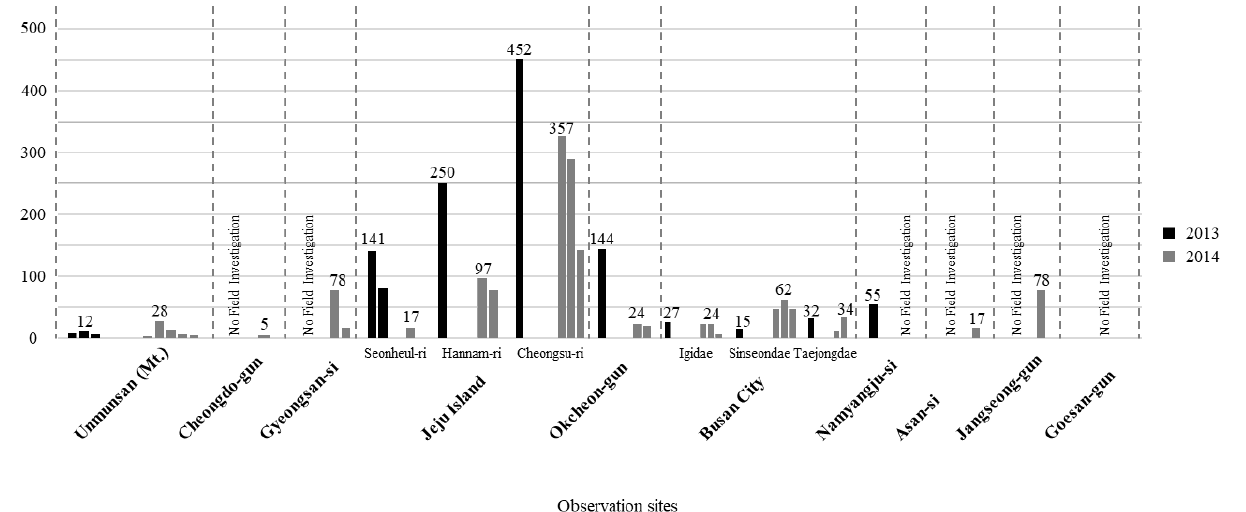
Table 4. Comparing organic matter and color of soil in the representative habitats of L. unmunsana. Site Name